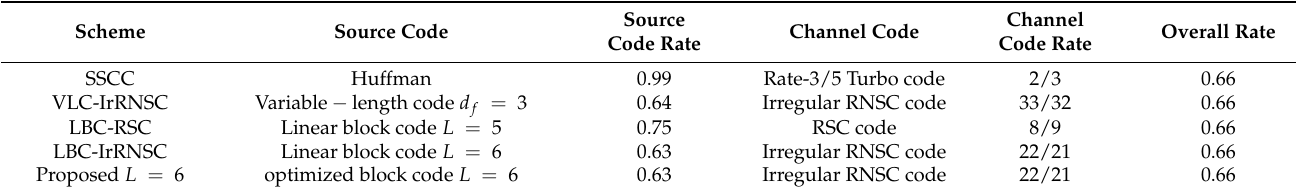
Table 3. Parameters of different source channel coding schemes.